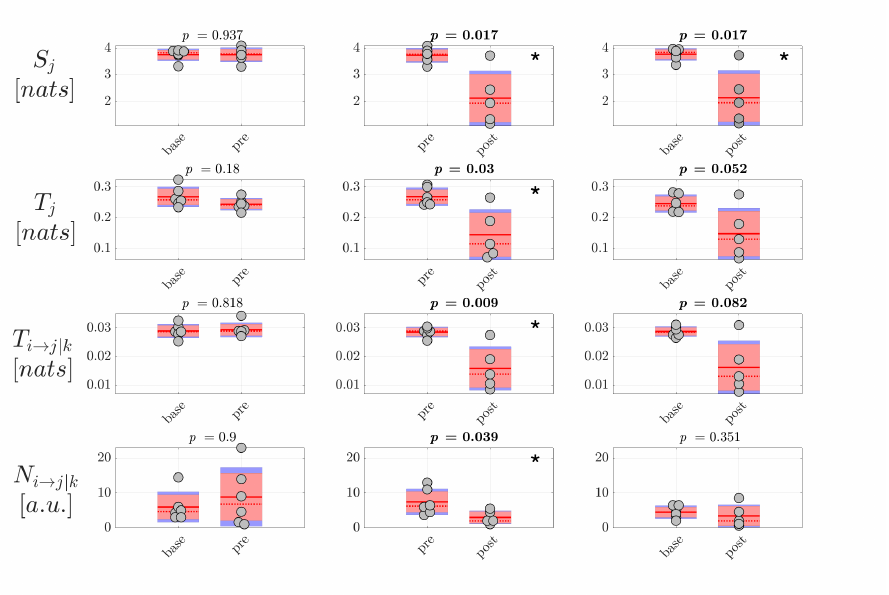
Figure 7. Information dynamics of source EEG signals measured during generalized seizures. Panels report the boxplot distribution and individual subject values (average over network nodes and trials) of the information storage S j , total information transfer T j , conditional information transfer T i → j | k , and number of significant links N i → j | k in the three analyzed conditions base , pre , post . Statistically significant difference between pairs of distributions ( p < 0.05) are marked with *; p -values < 0.1 are written in